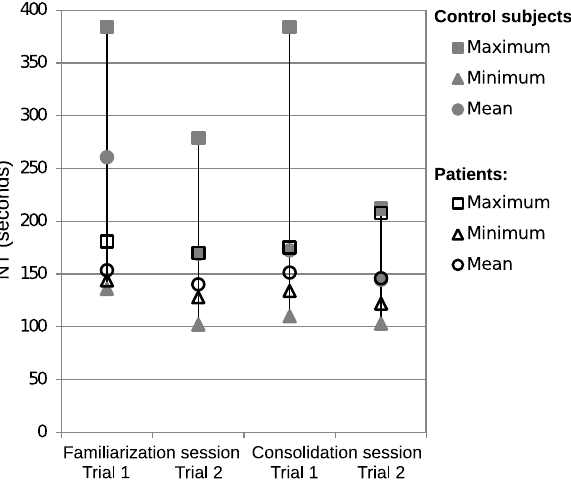
Figure 4. Performance index navigation time (NT) for the four trials with the state navigator tool for both the control subjects and the patients. Maximum, minimum, and mean of the NT values are